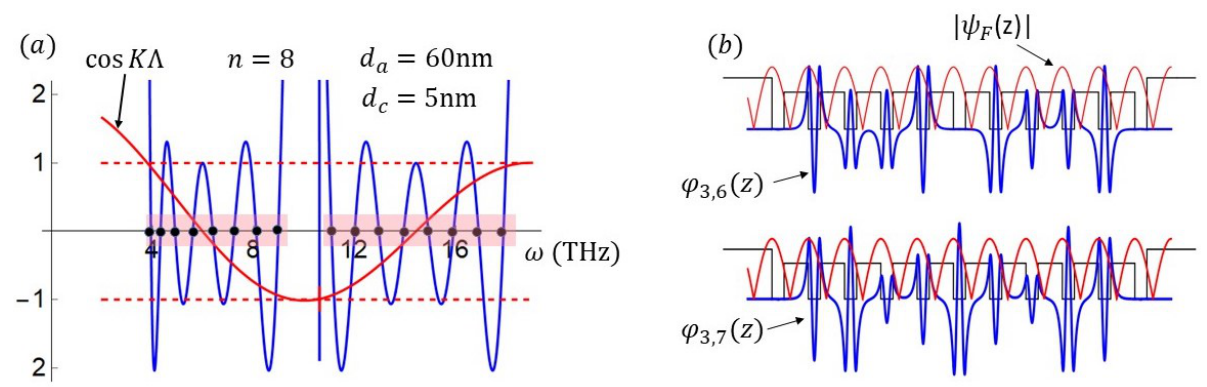
Figure 5. Dispersion relations and wave functions in finite and infinite periodic systems. ( a ) The continuous subbands predicted by the continuous dispersion relation (25) (see red rectangle) and the discrete intra-subband energy levels predicted by the discrete dispersion relation (refDDR)of the TFPS. Open systems are determined by the zeros of the Chebyshev polynomials (see black dots) [63,65]. ( b ) A plot of the absolute value of a Bloch–Floquet periodic function (red curve) and the eigenfunctions ϕ 3,6 and ϕ 3,7 (blue curves) for holes in a bounded GaAlN / ( GaN / GaAlN ) n superlattice (light black) with n =